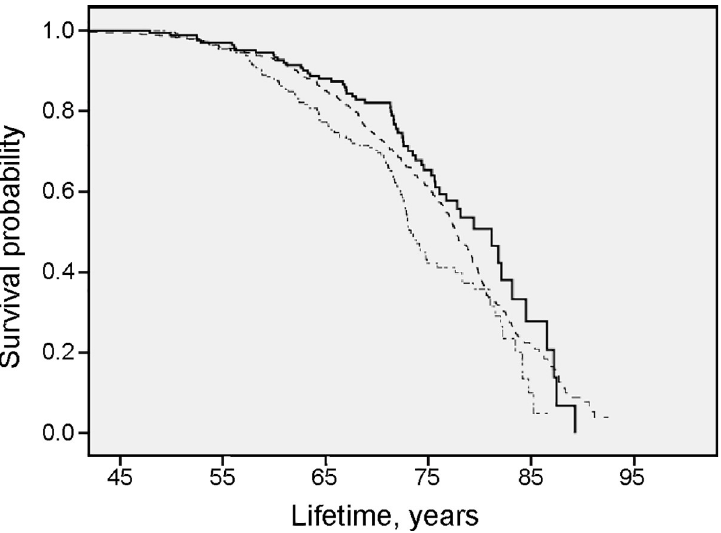
Fig 1. High all-cause mortality in male smokers. Survival probability for all-cause mortality in male smokers ( � ─ � � ─ � � ─ � ), former smokers ( ────── ) and nonsmokers (-—-—-—-) illustrated with results from Kaplan-Meier analysis.